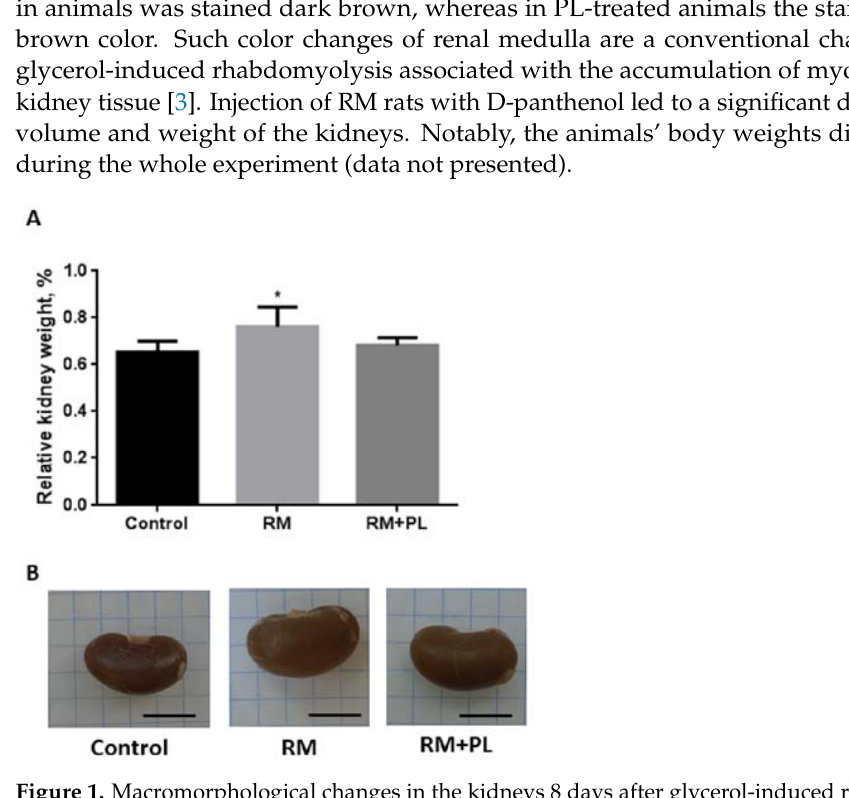
Figure 1. Macromorphological changes in the kidneys 8 days after glycerol-induced rhabdomyolysis and its treatment with D-panthenol: ( A ) changes in the relative weight of rat kidneys (%); and ( B ) rat kidney appearance on the 8th day after rhabdomyolysis. Scale bar, 10 mm. * p < 0.05 compared to